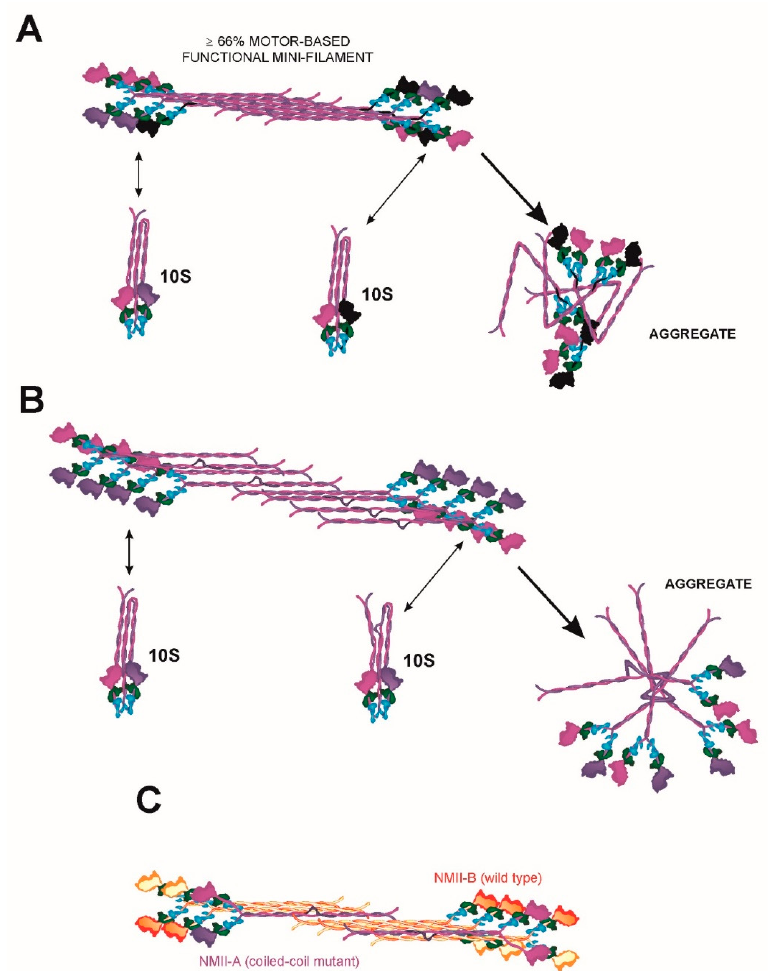
Figure 4. ( A ) Schematic representation of a mixed mini-filament including wild-type (magenta / purple) and a generic motor mutant (black) NMII-A. Functionality ( ≥ 66%) is calculated for the specific composition of the mini-filament (eight wild-type heads and four mutants). In this particular filament, functionality would be 66.6% if the mutant had 0% activity, as discussed in Section 6.1. Bottom left represents the exchange of wild-type NMII-A. Bottom right represents the folded conformation into three segments and the possibility that the mutant folds back into 10S normally, or does not fold back into 10S, aggregating in an aberrant conformation instead. ( B ) Schematic representation of a mixed mini-filament including wild-type (magenta/purple) and a generic coiled coil mutant (bulge in the coiled coil) NMII-A. Bottom left represents the exchange of wild-type NMII- A. Bottom right represents the possibility that the coiled coil mutant folds back into 10S, or cannot fold back into 10S, aggregating in an aberrant conformation instead. ( C ) Cartoon depicts the integration of NMII-A, wild-type (magenta/purple) or mutant (black) into mini-filaments with other NMII paralogs, e.g., NMII-B (in orange/red tones), which is thermodynamically feasible, as shown in [74]. Color codes of the different chains is as in Figure 1. 6.2. A Continuum of MYH9 Mutations that Causes Graded Protein Accumulation in Aggregates